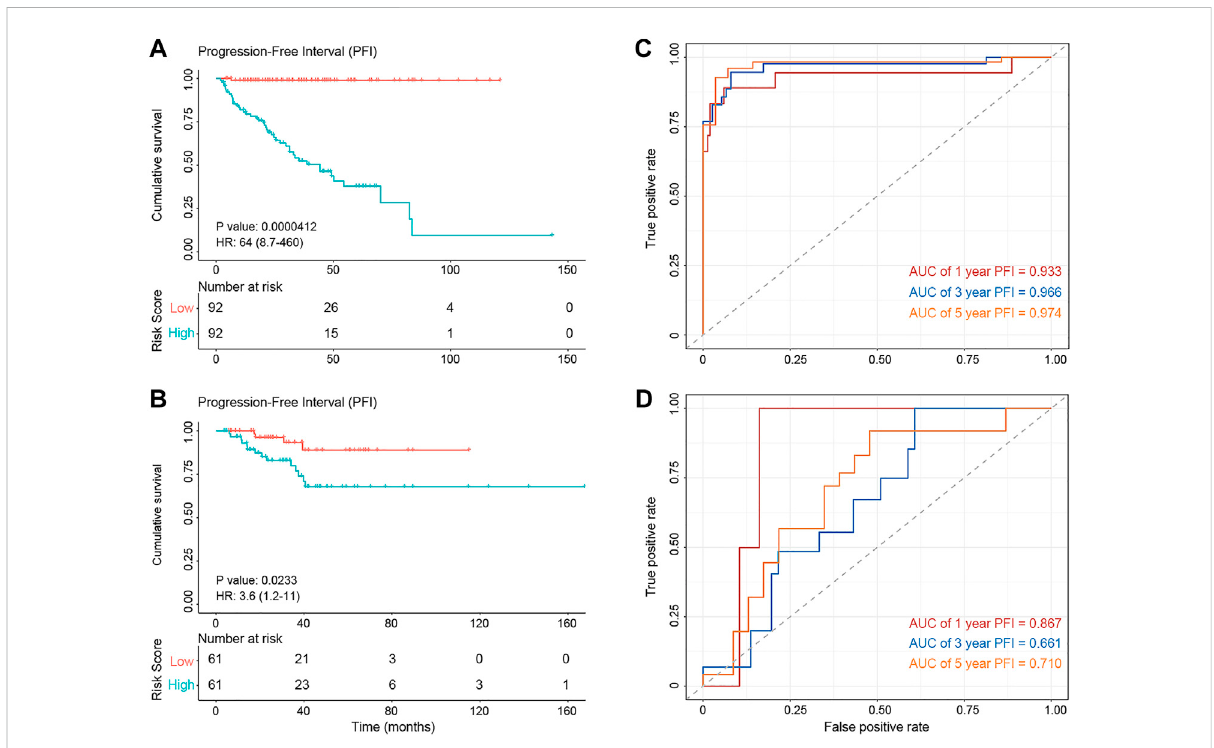
FIGURE 6 The diagnostic performance of the prognostic model. (A,B) Kaplan – Meier survival analysis showing PFI differences between the high-risk (red) and low-risk (blue) groups in the training set (A) and test set (B) . (C,D) The ROC curve showing the AUC value of the risk model in the training set (C) and testing set (D)